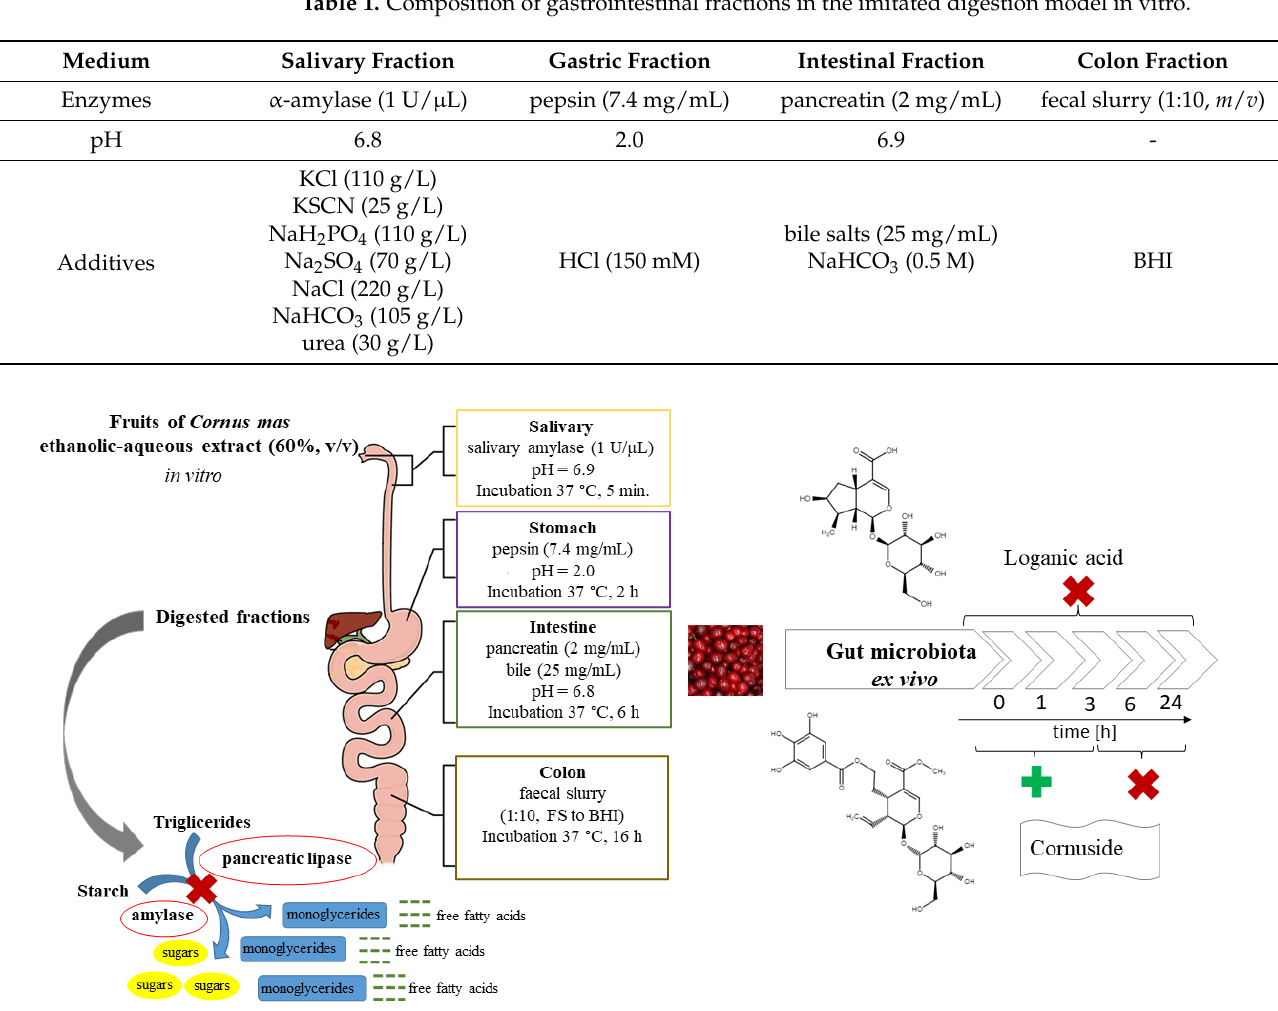
Table 1. Composition of gastrointestinal fractions in the imitated digestion model in vitro.